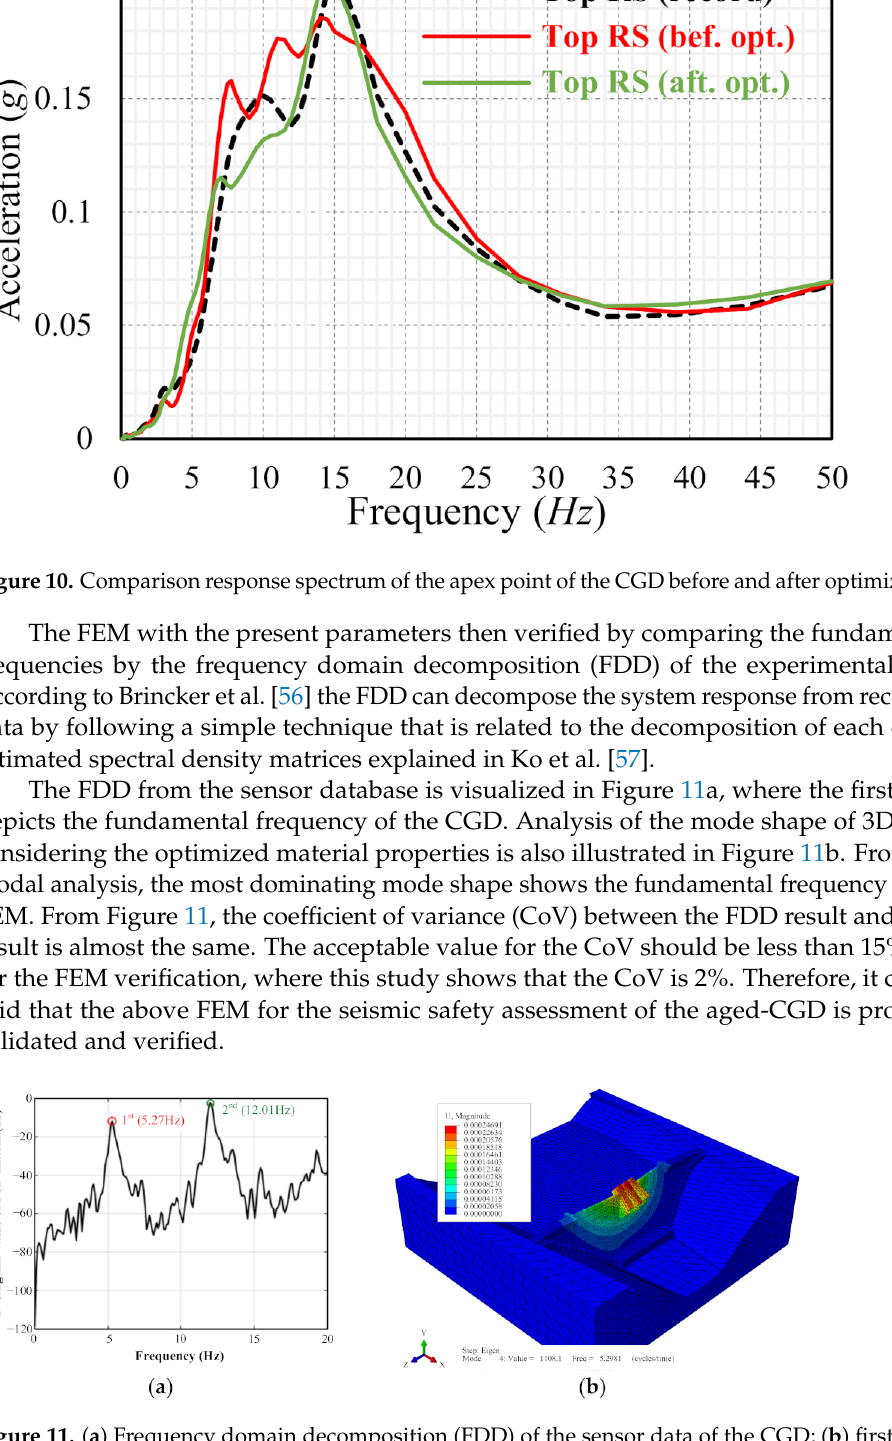
Figure 11. ( a ) Frequency domain decomposition (FDD) of the sensor data of the CGD; ( b ) first mode shape of